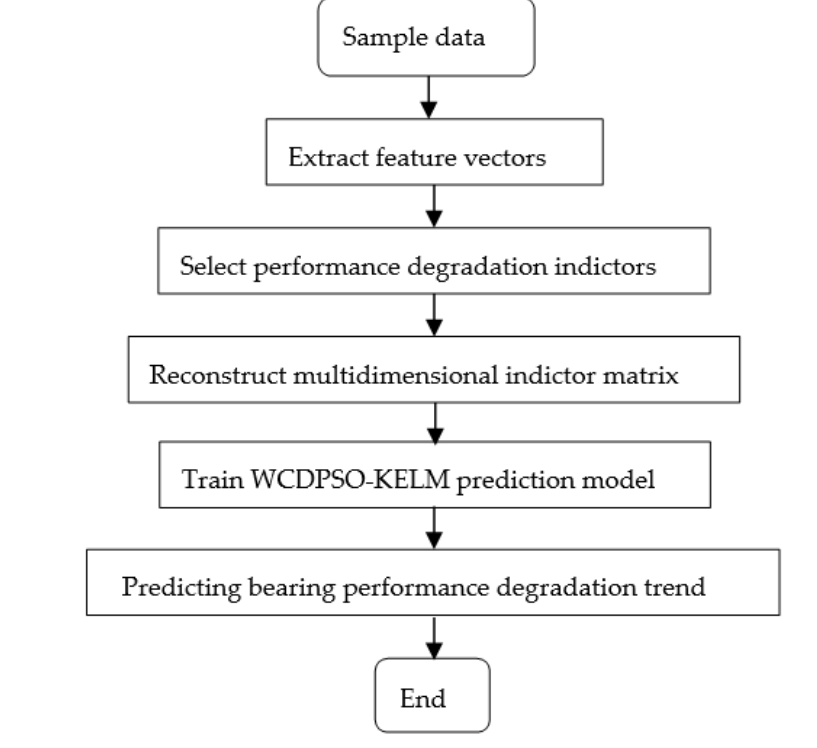
Figure 3. Flowchart of prediction model based on WCDPSO-KELM method. Table 1. MAPE value of different